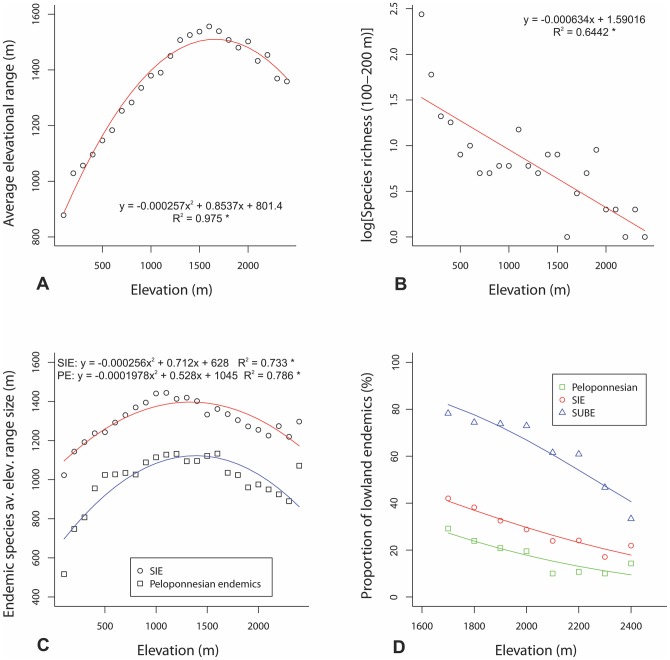
Data on the elevational range size of the vascular plants.(A) average elevational range of total species, (B) log-transformed total number of species with a very narrow elevational range (100–200 m), (C) average elevational range of Cretan endemics (circles) and Peloponnesian endemics (squares) and (D) proportion of lowland species in the upper one-third of the elevational gradient for Cretan subendemics (triangles), Cretan endemics (circles) and Peloponnesian endemics (squares). Trend lines were set by simple regressions (A, B, C) and generalized linear models (D). (* p<0.001).